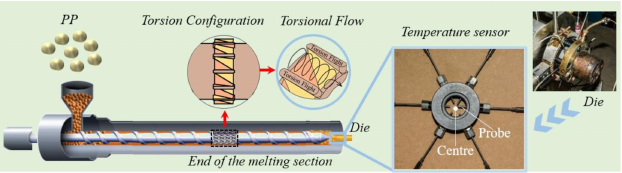
Figure 5. The experimental extruder with a radial temperature measurement in the position of the